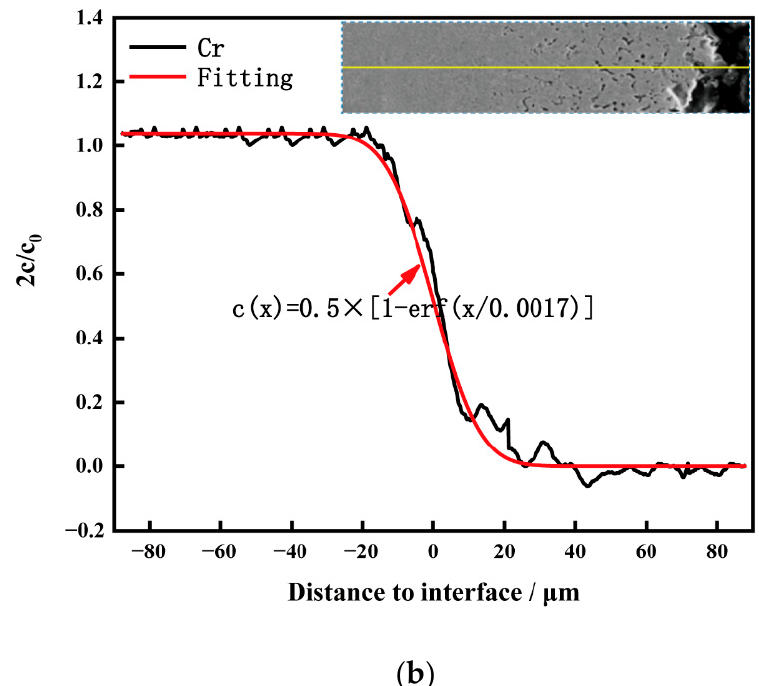
Figure 11. Element distribution of Cr between the matrix and corrosion layer in weld claddings. ( a ) Nitrogen ‐ containing low ‐ nickel weld cladding 3. ( b ) Inconel 625 weld cladding.